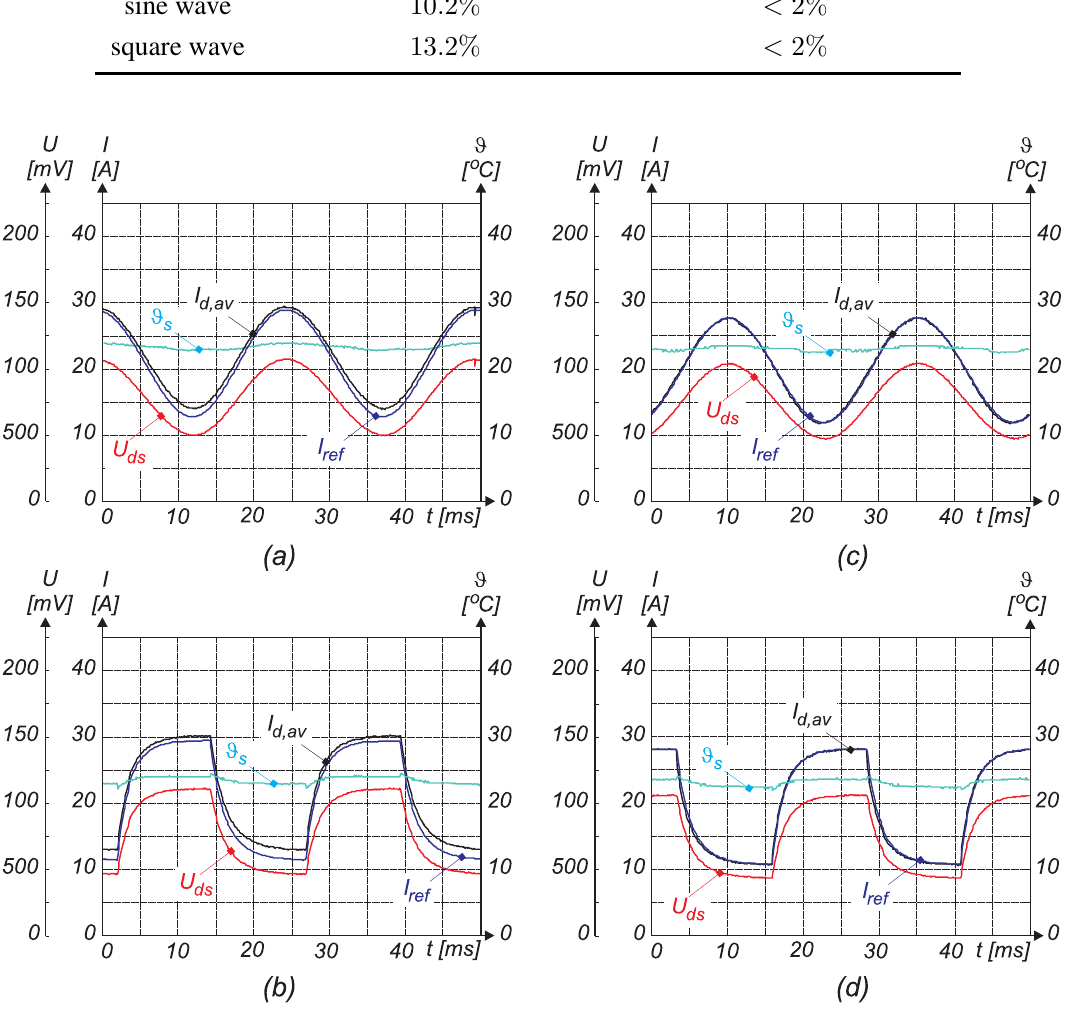
Figure 14. Sine wave and square modulation when (cid:14) 2 ( 0.1–0.3); (a) measured U